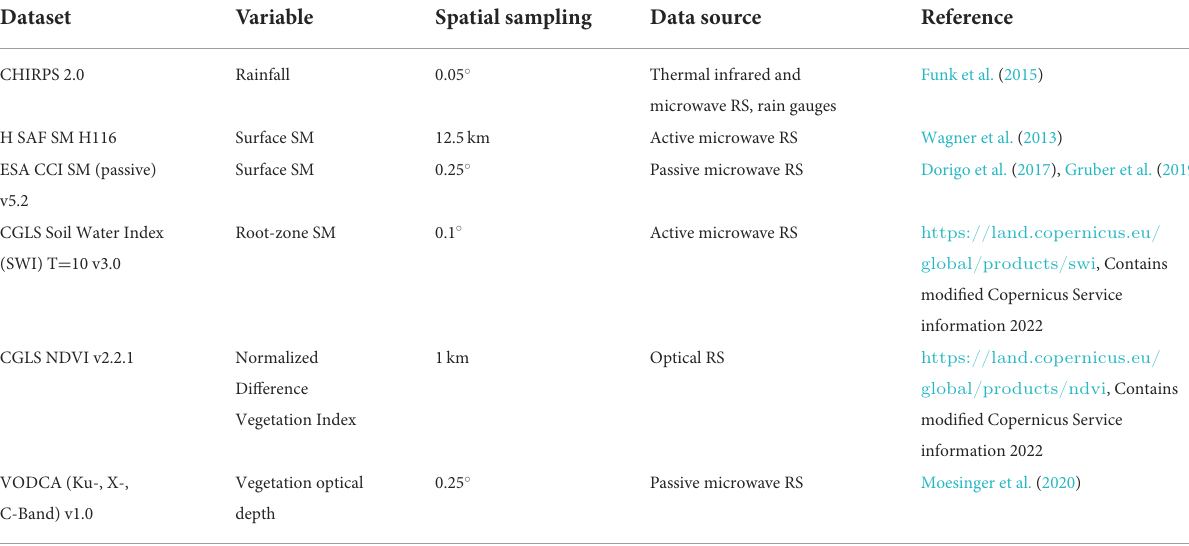
TABLE 3 Datasets used in the case study for Senegal and their main characteristics.